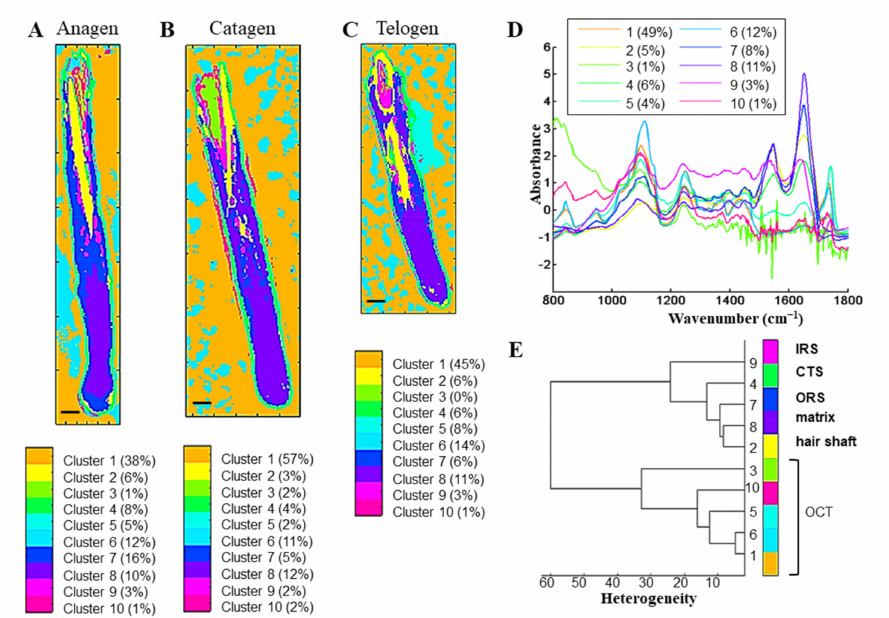
Figure 4. Discrimination of hair follicle structures at different phases of hair growth cycle by k -means clustering. ( A – C ) Representative color-coded k -means clustering images using 10 classes in the 1800–800 cm − 1 spectral range for hair follicles in anagen A1 ( A ), catagen C1 ( B ), and telogen T1 ( C ) phases. ( D ) Centroid spectra corresponding to each cluster. ( E ) Dendrogram of centroid spectra and assignment of corresponding hair follicle structures. CTS, connective tissue sheath; IRS, inner root sheath; ORS, outer root sheath. Scale bar: 100 µ